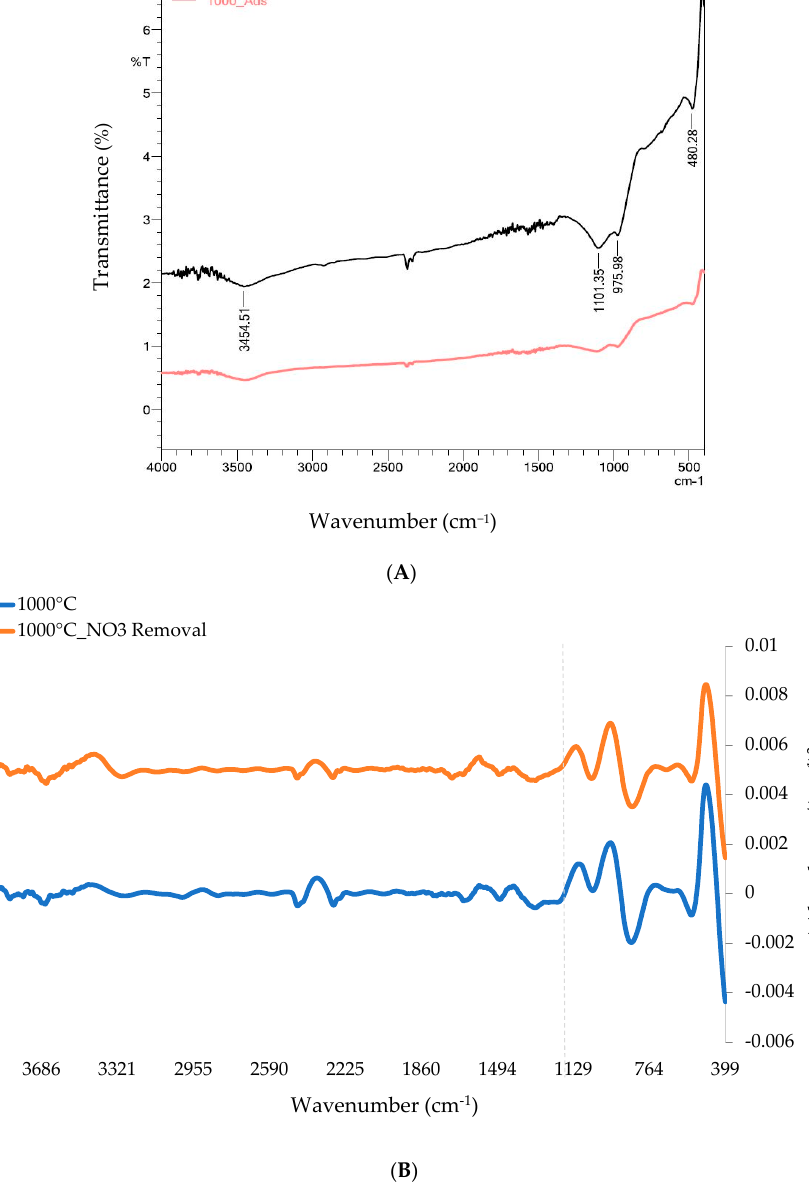
Figure 8. FTIR spectra of MBC prepared at 1000 °C before and after nitrate adsorption ( A ) and the second derivative FTIR spectra of MBC prepared at 1000 °C before and after nitrate adsorption ( B ).